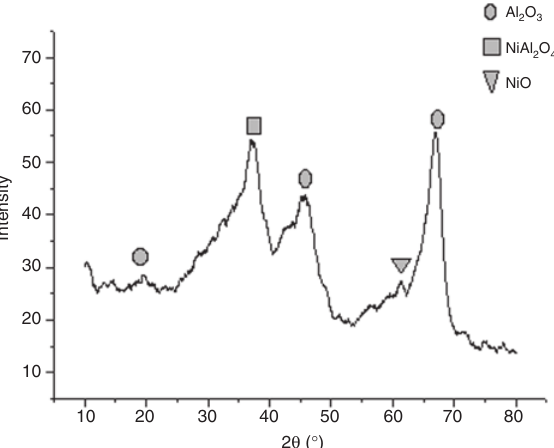
Figure 5: The XRD spectrogram of the bimetallic catalyst MnO -NiO/ γ -Al O 2 2 3